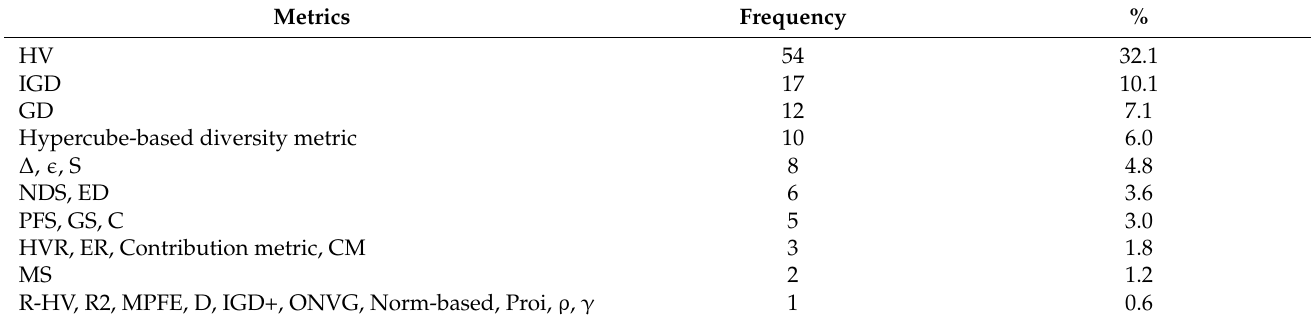
Table 3. Units for list rank of used